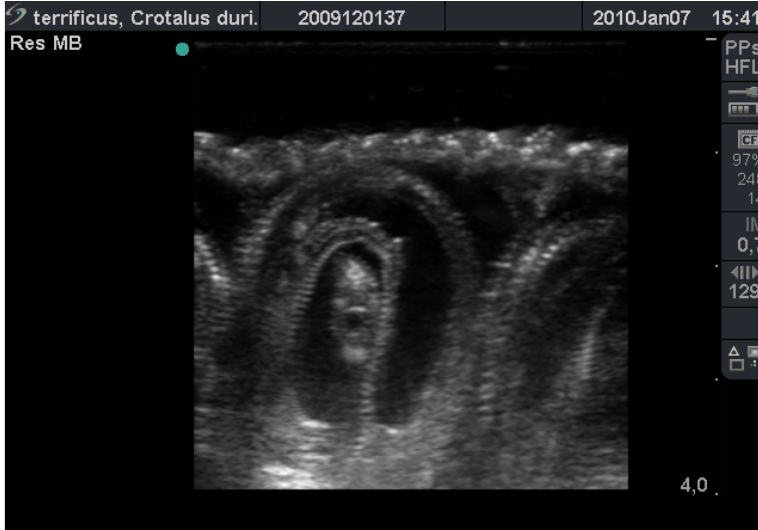
Figure 6. Ultrasound image of Crotalus durissus